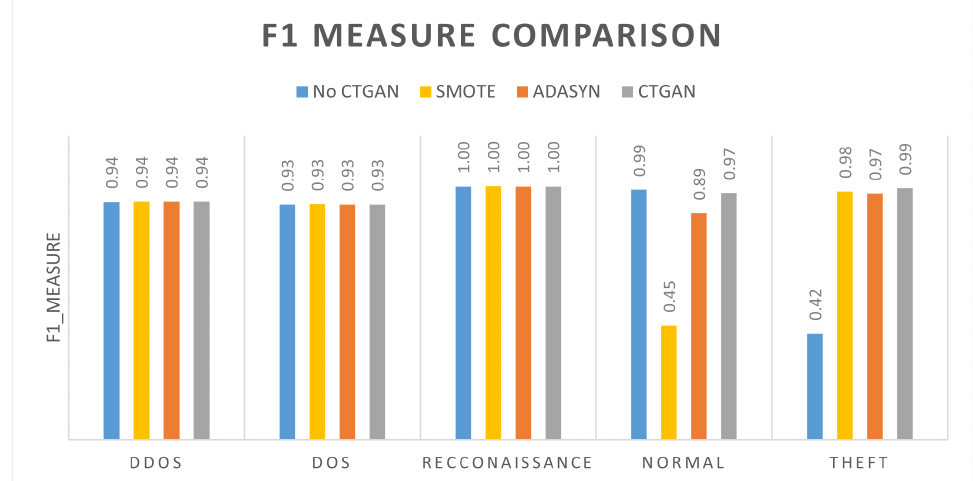
Figure 7. F1 measure after Oversampling. Comparison among SMOTE, ADASYN, and CTGAN.